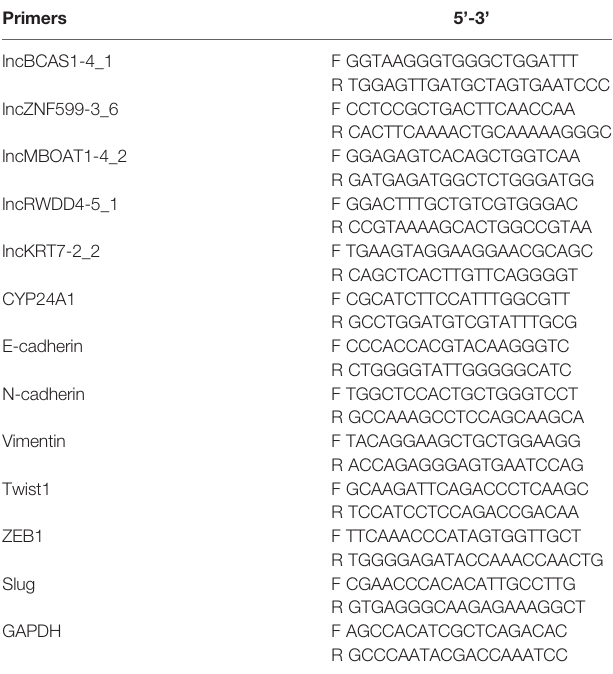
TABLE 1 | Primer sequences for